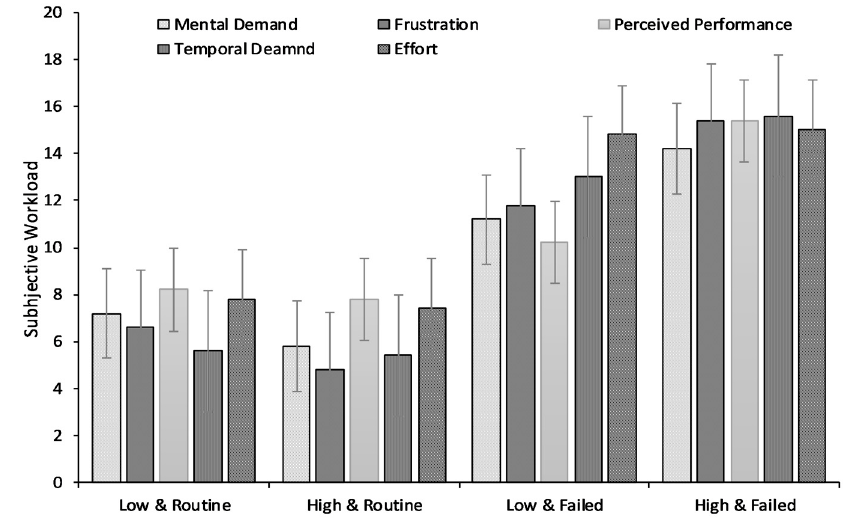
Figure 5. NASA TLX subscale scores by levels of automation.